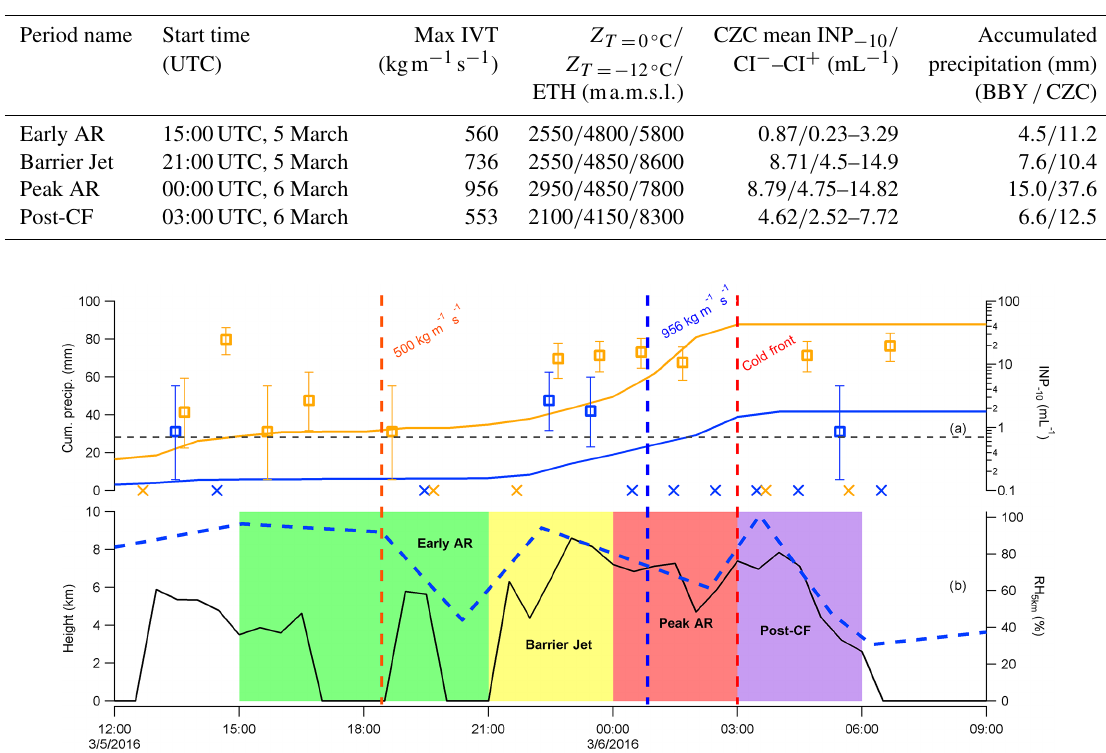
Table 3. Kinematic periods, their beginning and end time, maximum sounding-derived IVT, height of cloud layers (see Sect. 3b) used for FLEXPART analysis, mean INP − 10 and accumulated precipitation at each site.